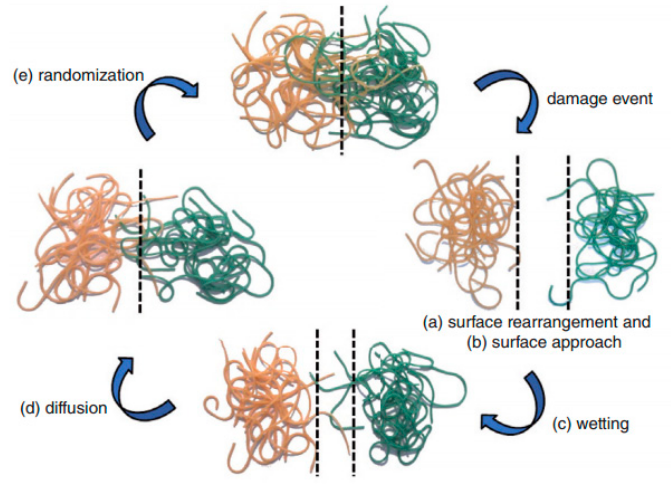
Figure 2. Stages of self-healing mechanism surface rearrangement ( a ), surface approach ( b ), wetting ( c ), diffusion ( d ) and randomization ( e ) (reproduced from [9] with permission from John Wiley and Sons).